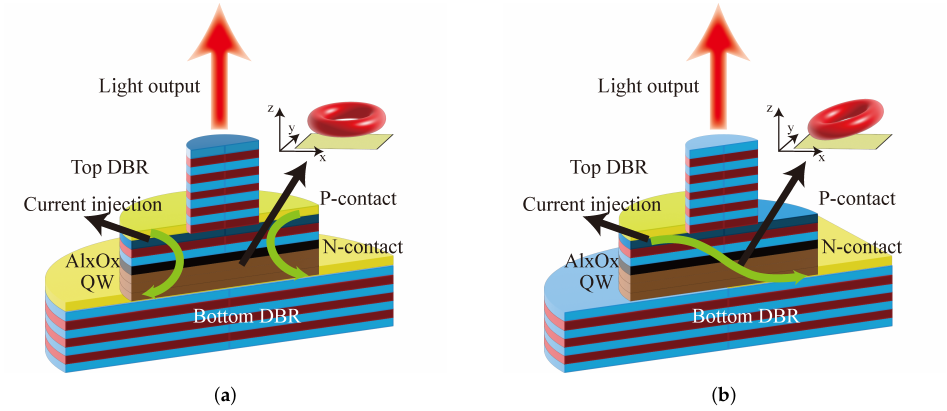
Figure 9. ( a ) VCSEL with symmetric current injection; ( b ) VCSEL with asymmetric current